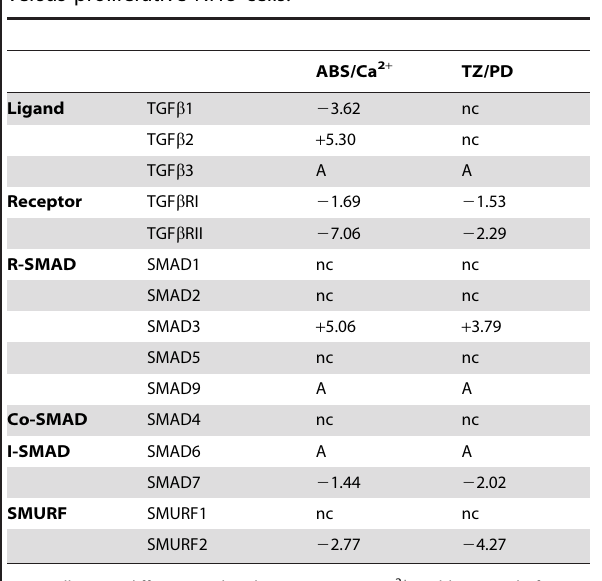
Table 2. Affymetrix TM genechip analysis in differentiated versus proliferative NHU cells.